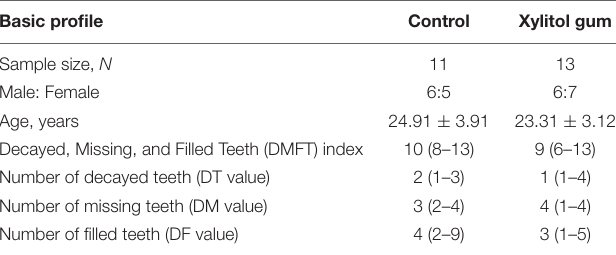
TABLE 1 | Characteristics of participants from the control and xylitol gum